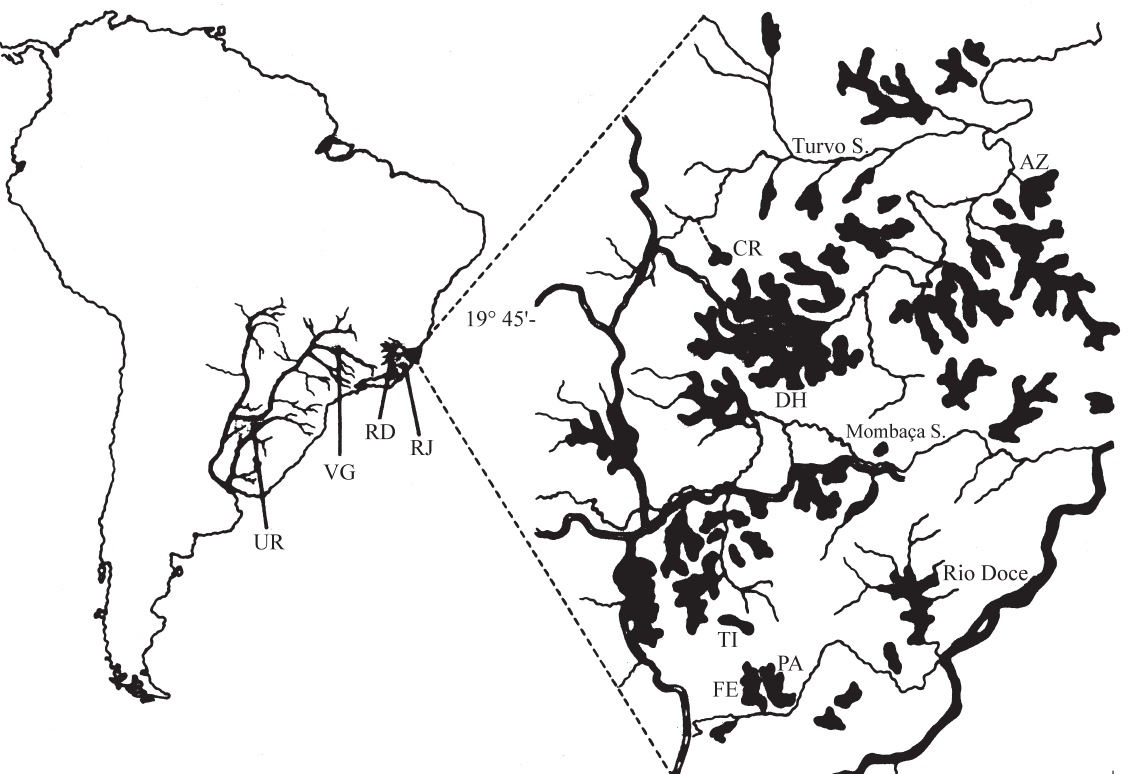
Figure1 -Mapofthecollectionsitesof Hopliasmalabaricus .IntheRioDocebasin: AZ ,lakeAzul; CR ,lakeCarioca; DH ,lakeDomHelvécio; FE ,lake Ferrugem; OR , Municipality of Belo Oriente; PA , lake Palmeiras; TI , lake Timburé; VI , Viçosa. In Rio de Janeiro State, RJ refers to Macacu.